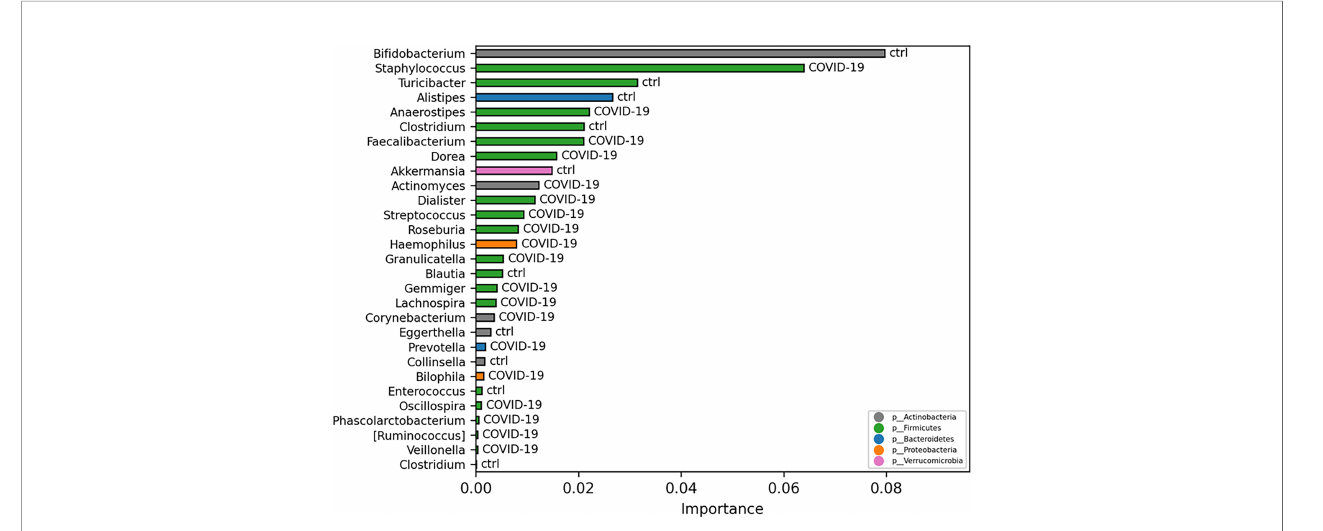
FIGURE 6 | Important ASVs selected by model classi fi cation analysis. The bars represent the importance scores of each ASV in the prediction of